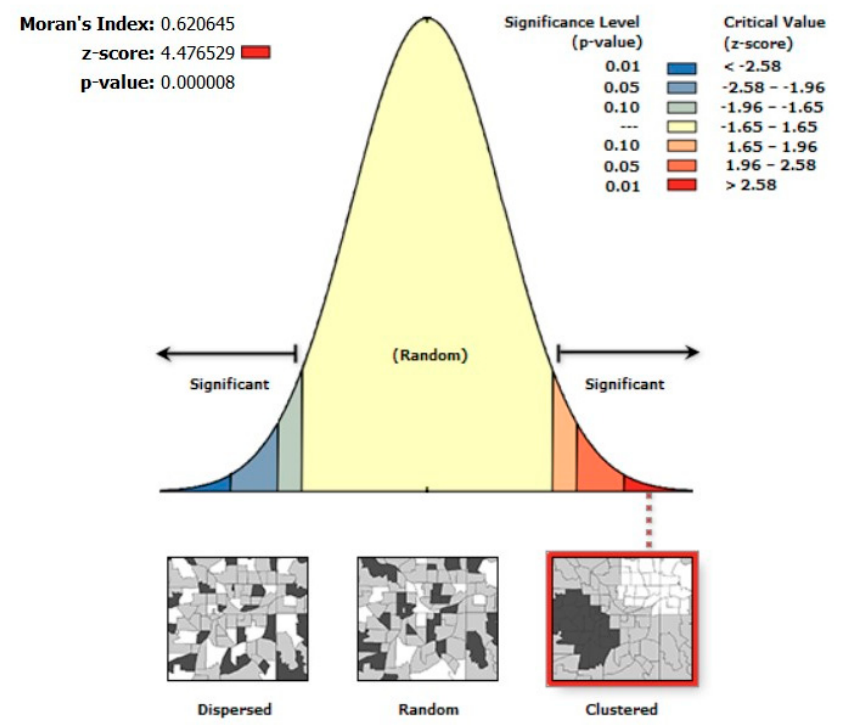
Figure 7. Moran’s I distribution for ETI in Europe. When analysing its contents, it can be noticed that the values of the Moran I statistics are positive and statistically significant, which proves that European countries are clustered; in the case of Asia, such clustering did not take place (Figures 9 and 10), and the ETI values are distributed randomly. An analogous analysis was performed for the ETI subindices (System Performance and Transition Readiness) for each continent, using both the original and optimised